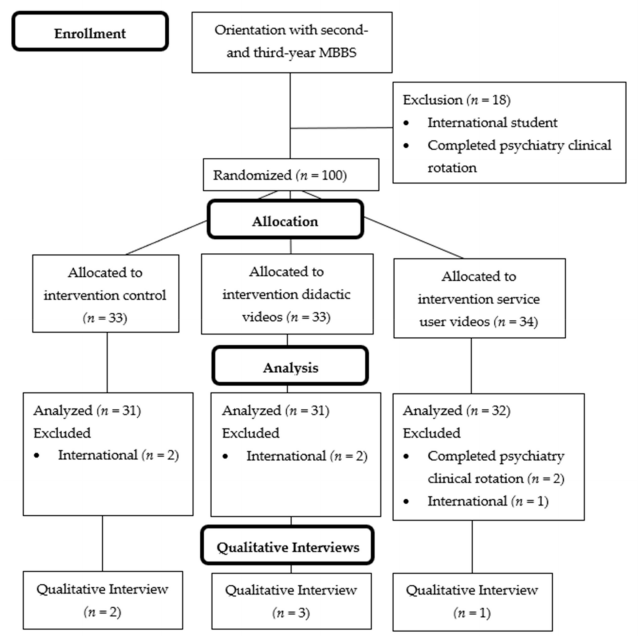
Figure 1. CONSORT flow diagram for research procedures in Study 1 (depression only). Note: in the service user video study arm, one participant excluded at the analysis phase met both the psychiatry rotation and international exclusion criteria. Abbreviations: MBBS, Bachelors of Medicine, Bachelors of